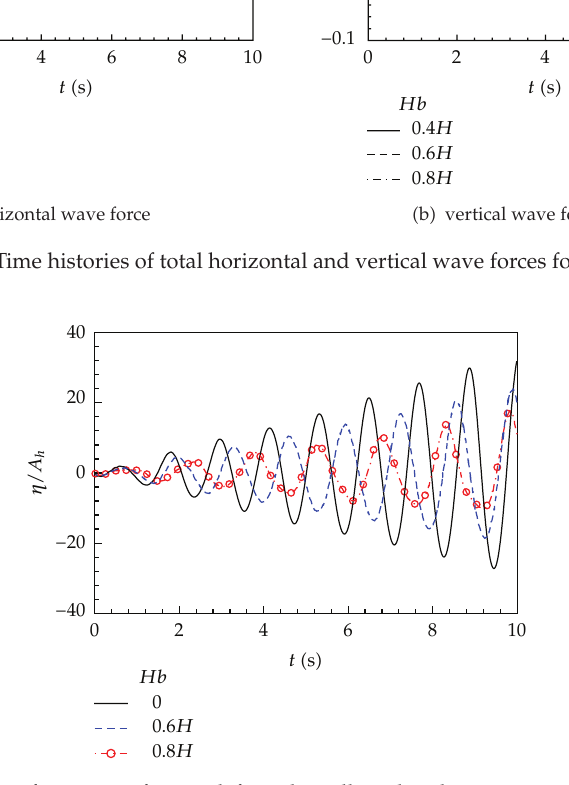
Figure 20: Time history of wave surface at left tank wall under the excitation of first-order natural